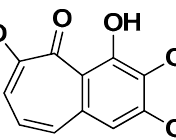
Figure 11. Schematic representations of the ( a ) iron(III) T p CPP chloride ligand, the ( b ) Zr 6 O 8 (CO 2 ) 8 (H 2 O) 8 SBUs and the ( c ) hexagonal and triangular one-dimensional channels of the crystal structure of MMPF-6. Color scheme: C, gray; O, red; Cl, green; Zr, turquoise. Reprinted (adapted) with permission from [35]. Copyright (2012) American Chemical Society. Molecules 2016 , 21 , 1348 15 of 18